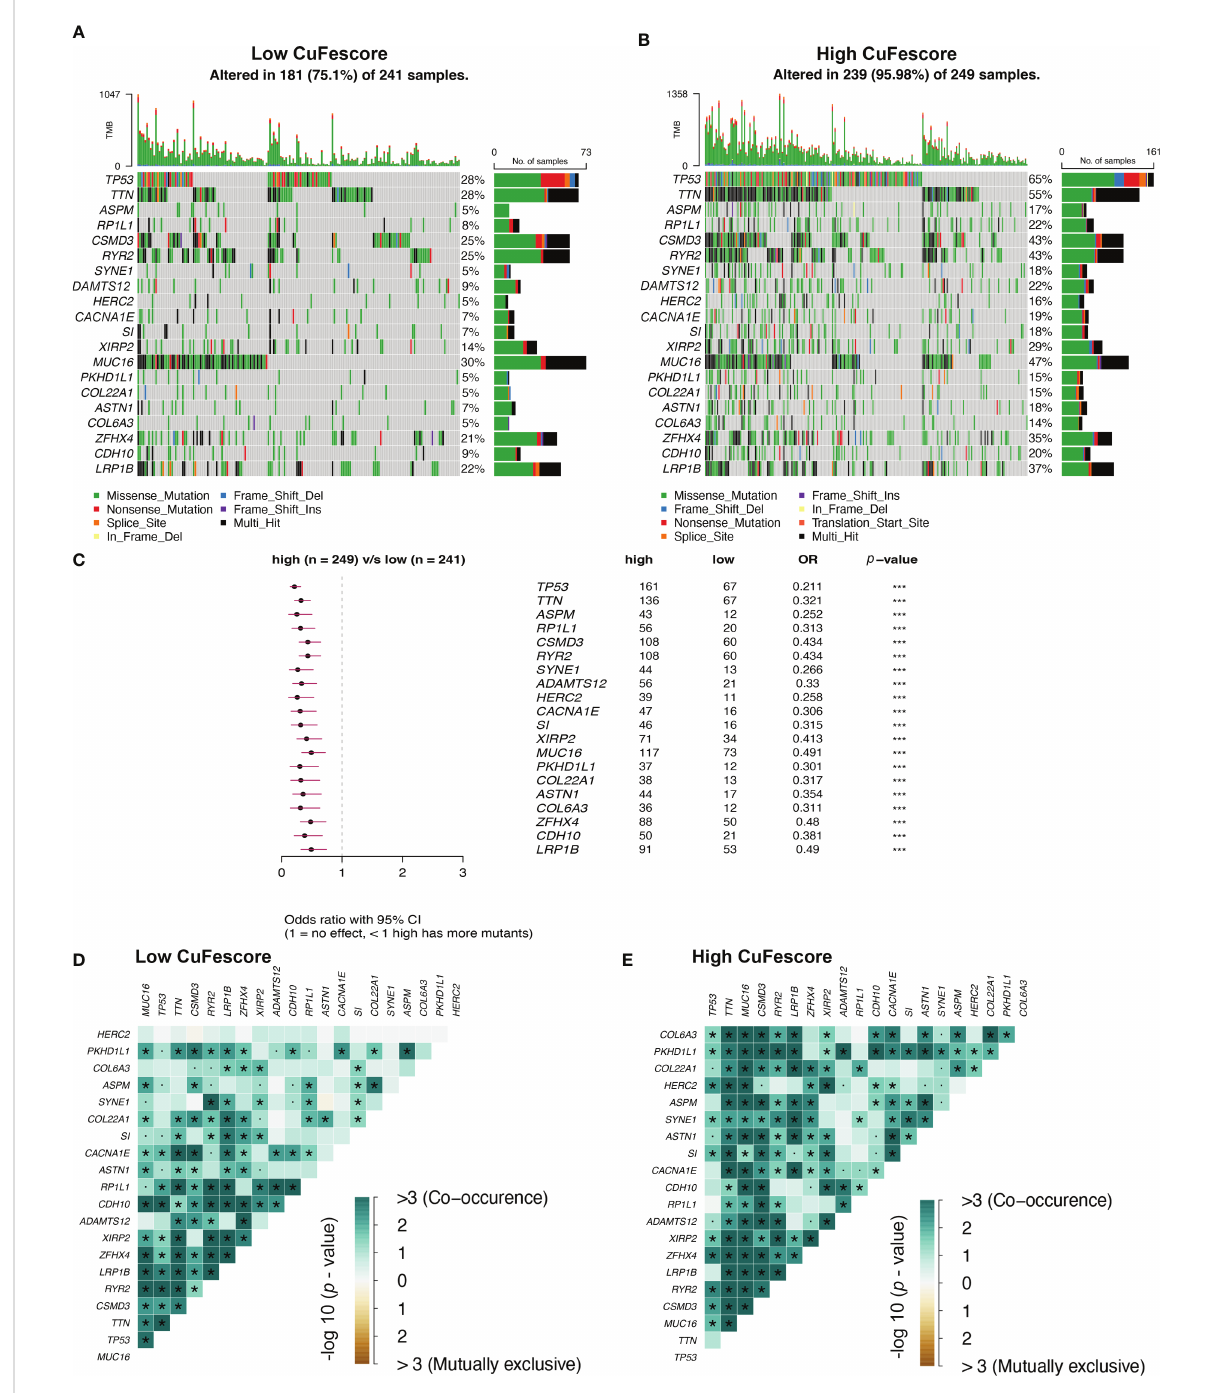
FIGURE 7 Association between the CuFescore and tumor mutation status. Visual summary showing common genetic alterations in the (A) low and (B) high CuFescore groups. (C) Forest plot of gene mutations in the patients. Interaction effect of genes mutating differentially in patients in the (D) low and (E) high CuFescore groups. p < 0.1, * p < 0.05, *** p <